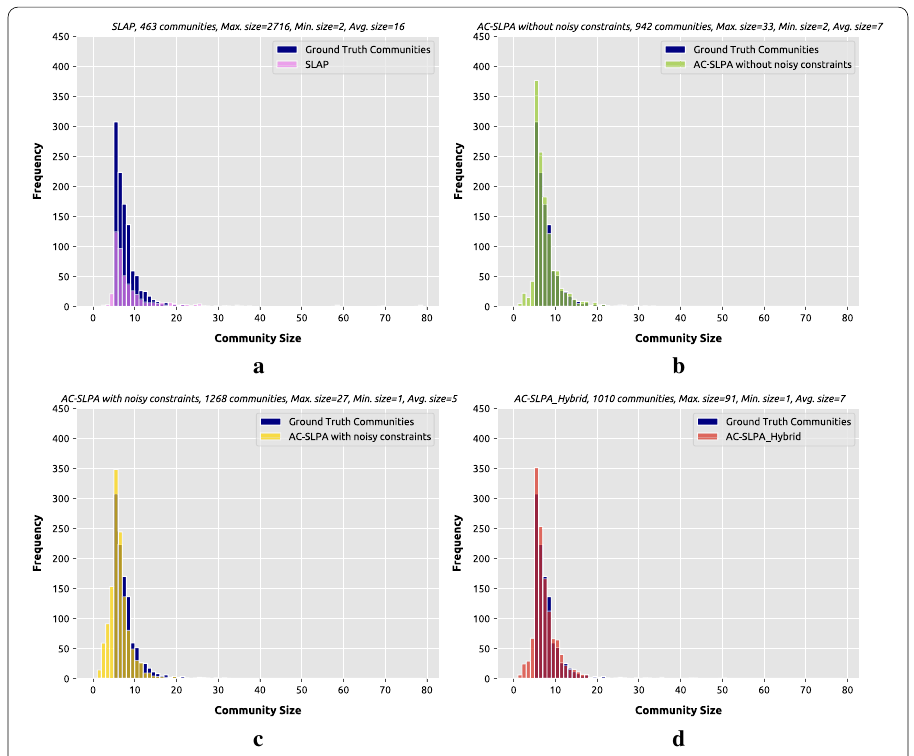
Fig. 13 Community size distribution for communities produced by SLPA, AC-SLPA with noisy pairwise constraints, and AC-SLPA with Hybrid cleaning on the YouTube network, compared to the ground truth community size